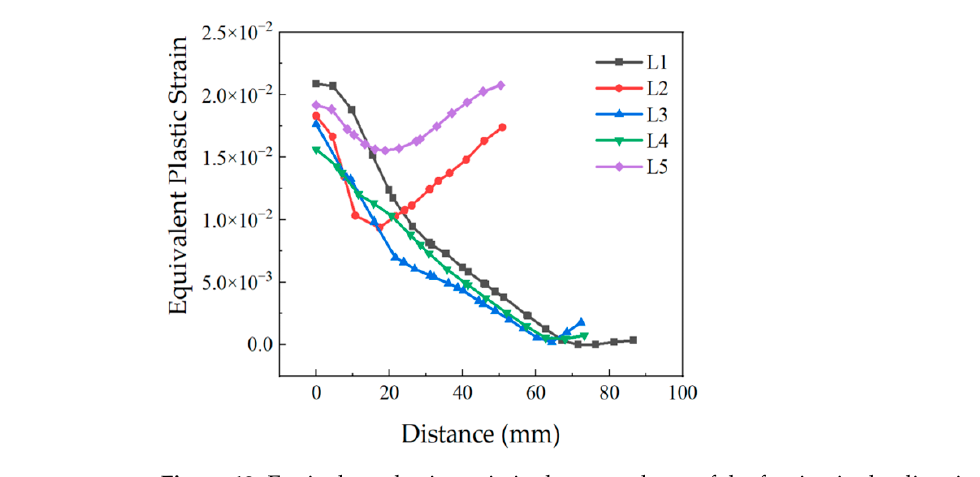
Figure 12. Equivalent plastic strain in the centre layer of the forging in the direction of the diameter of the expanded hole.